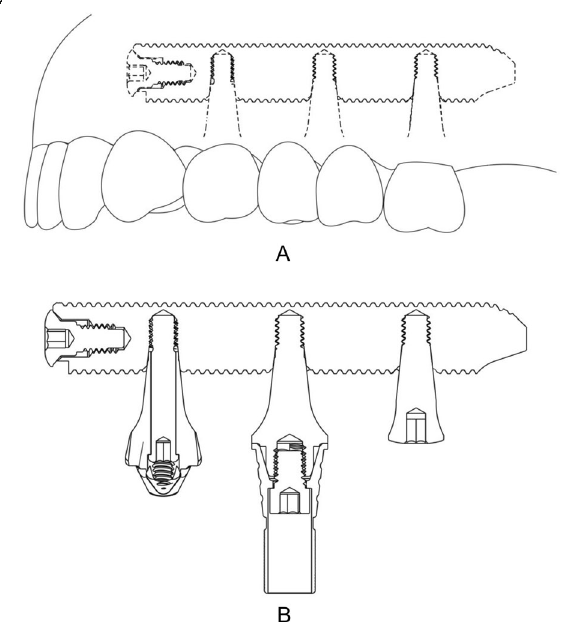
Fig. 1 Schematic drawing of the transmaxillary implant. Perforation is made using the 2.0 mm lance implant, for giving guidance and stability to the next drill, using the 3.0 mm implant